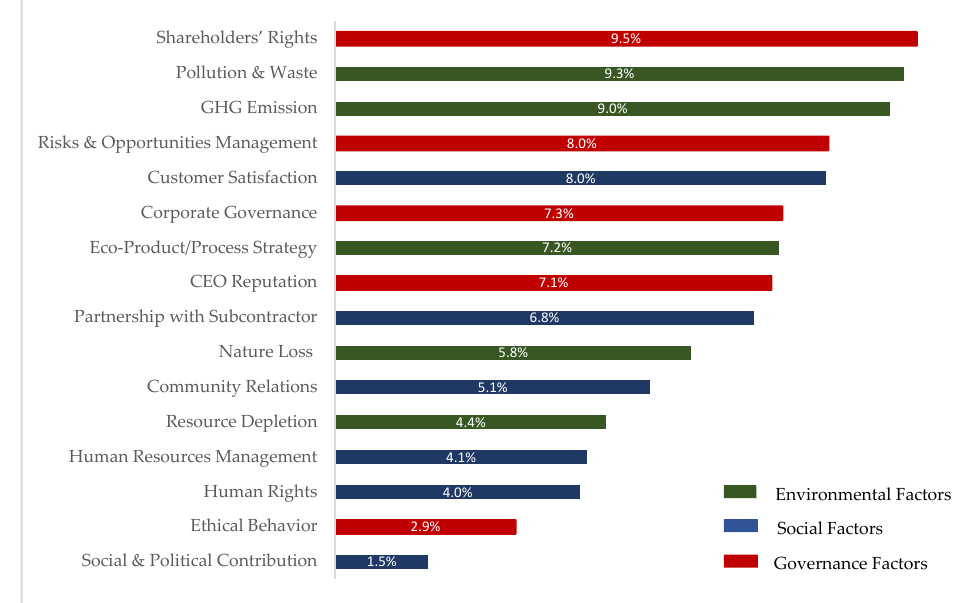
Figure 7. Global weights.